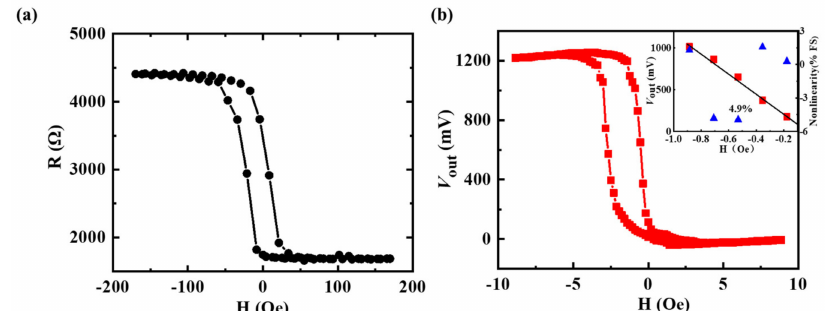
Figure 5. ( a ) R-H curve of one arm without the MFC, ( b ) output voltage of the magnetic sensor with the double-gap MFC in response to external magnetic field under the applied voltage of 2.5 V (the insert figure highlights the nonlinearity of the curve in the working range).